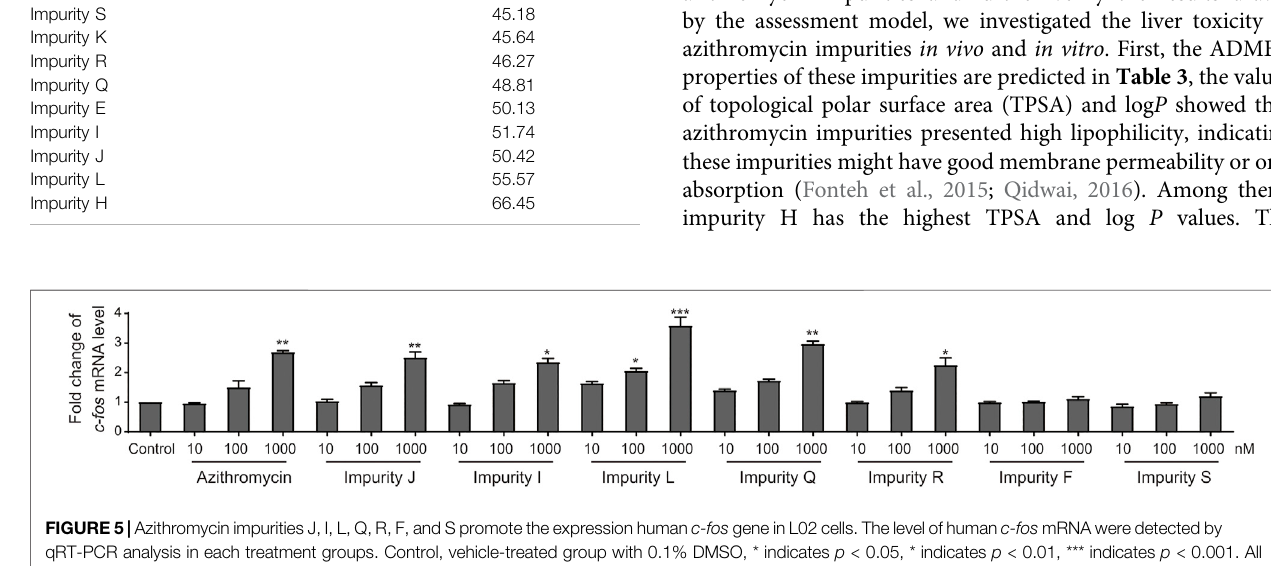
TABLE 2 | Docking scores of the highest -CDOCKER interaction energy for azithromycin impurities. Compound -CDOCKER interaction energy Impurity F